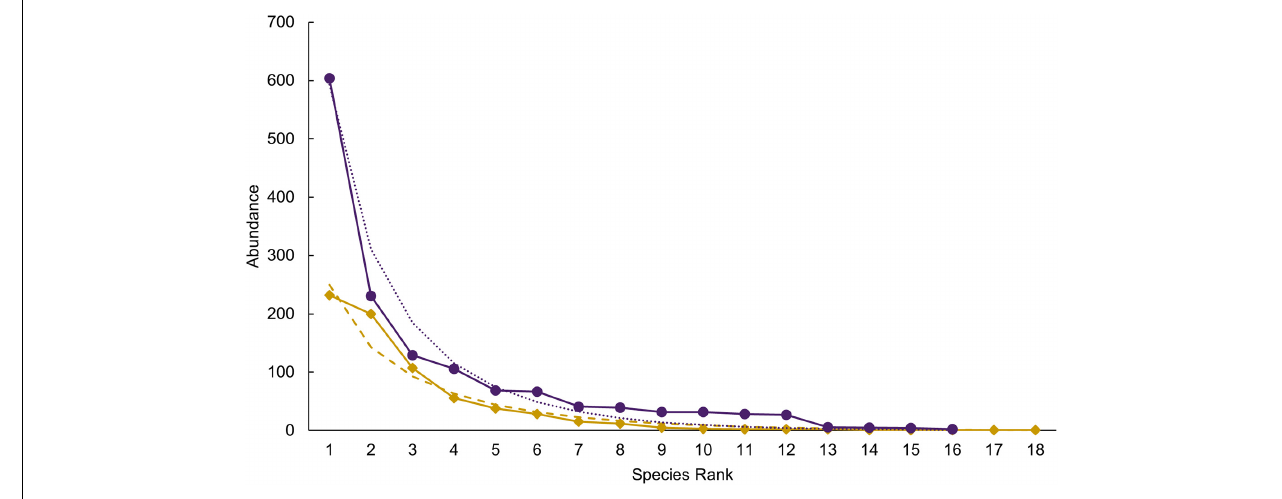
FIGURE 2 | The epiphyte rank abundance followed a log-series distribution in both the unlogged (dots and solid line in purple) and the selectively logged forest (diamond and solid line in gold). Species abundances are ranked with model estimates shown in purple dots (unlogged) and gold dashes (selectively logged). third most abundant species in the unlogged forest ( Figure 3